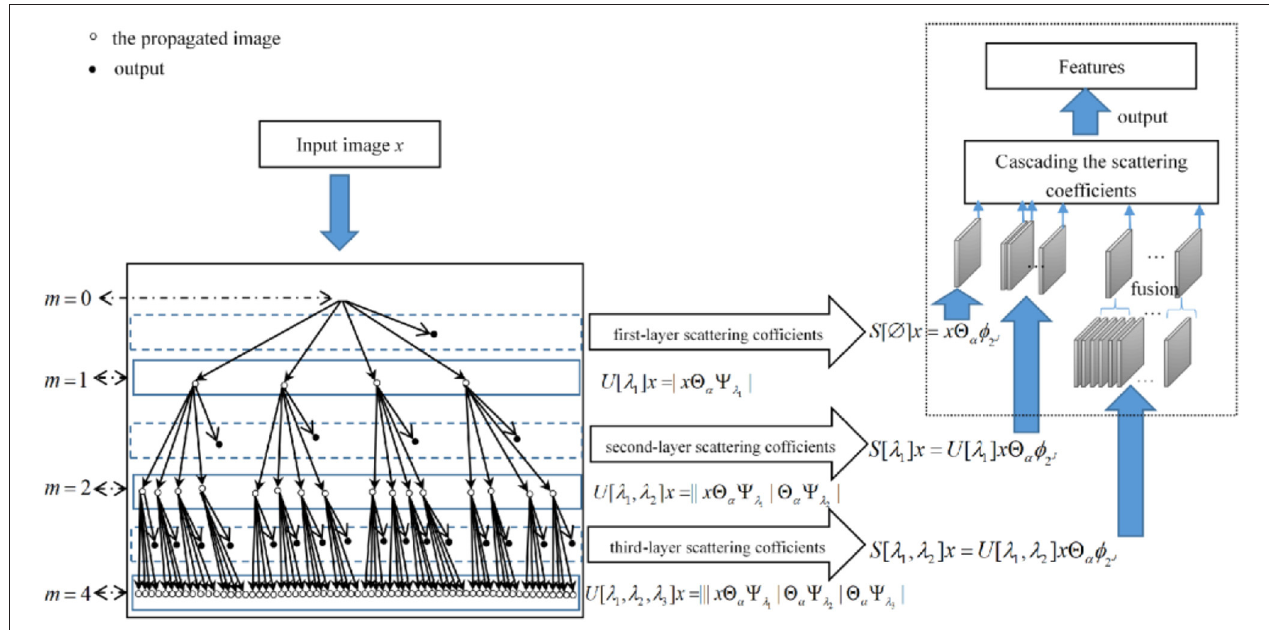
FIGURE 3 | Fractional wavelet scattering network and the feature-map fusion dimensional reduction method.